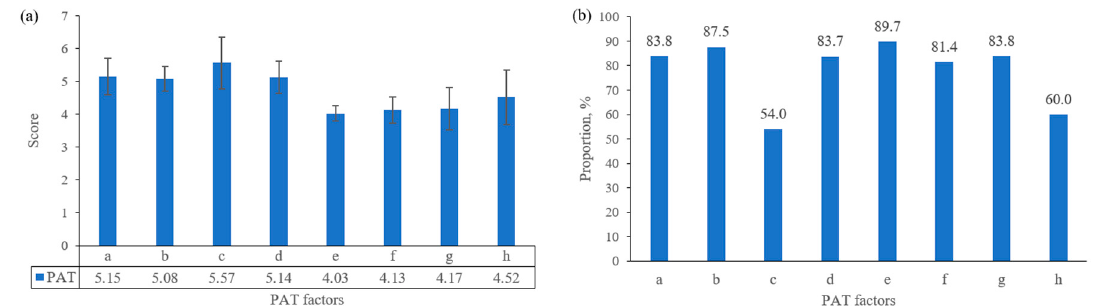
Figure 3. Parenting quality at 18 months of children. ( a ) PAT scores of different facts; ( b ) proportion of good parenting quality at 18 months. a. parenting concepts; b. acceptance; c. parent–child relationship; d. learning material; e. language stimulation; f. outside activity; g. feed; h. safety.